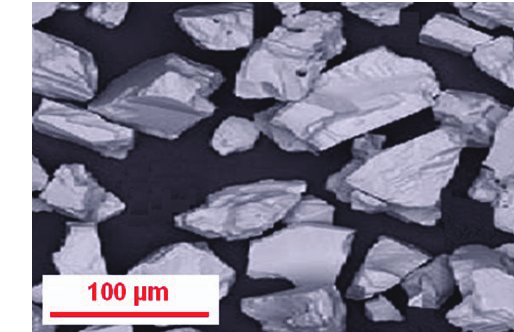
Figure 1 – (SEM) micrography of Cr 2 O 3 powder particles Рис . 1 – (SEM) микрография частиц порошка Cr 2 O 3 Слика 1 – (SEM) микрографија честица праха Cr 2 O